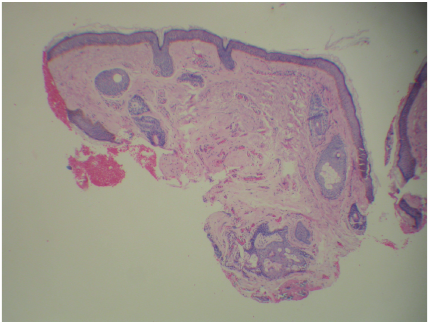
Figure 2: Histopathology showing central intradermal area of hyaline fibrosis and vascular neoproliferation where the osteoma became detached (HE, 100x).